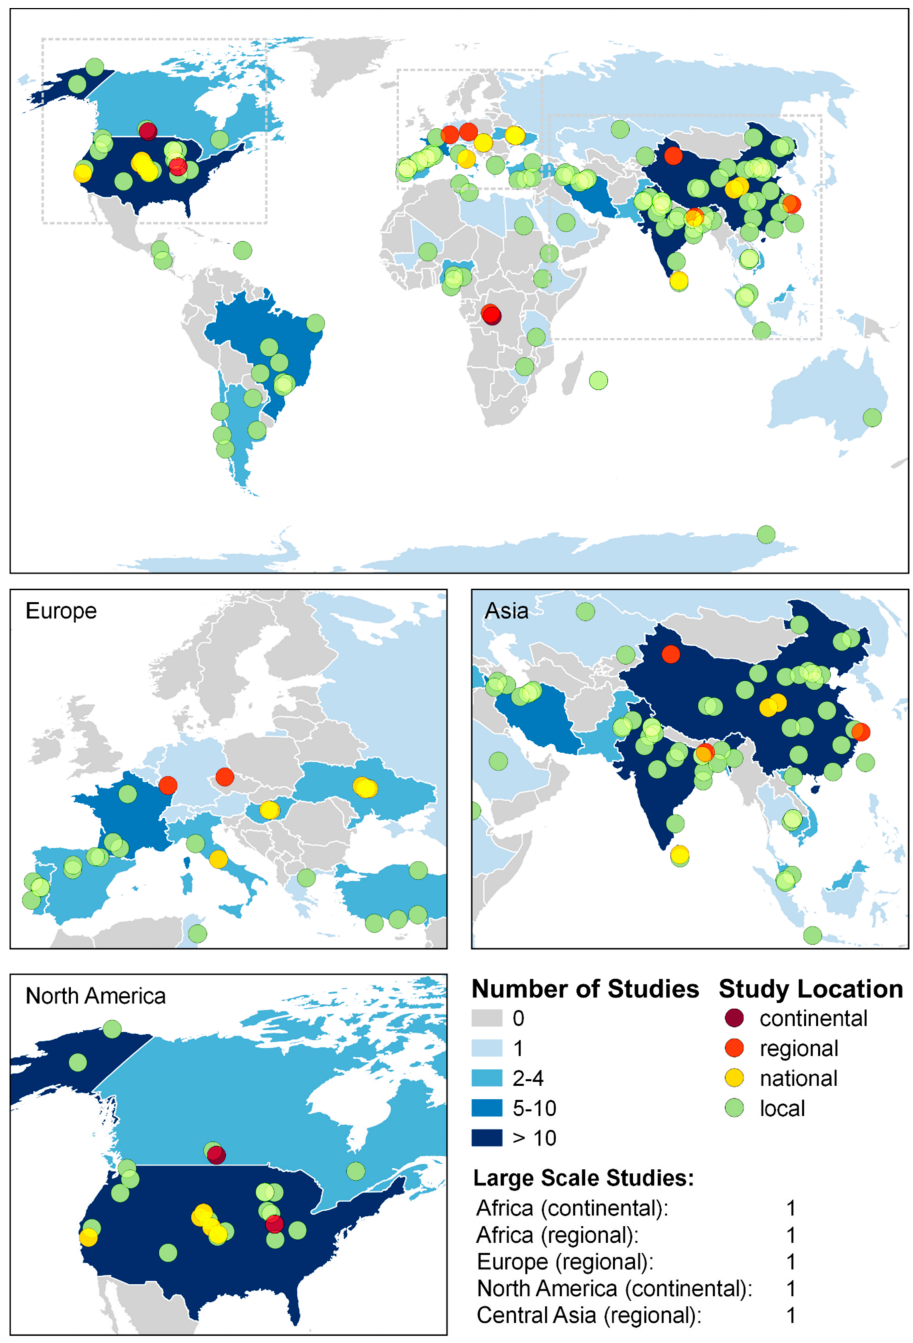
Figure 3. Number of EO-based forecast studies per country, geographical location and spatial scale of the respective study areas. One study may have been conducted on multiple study